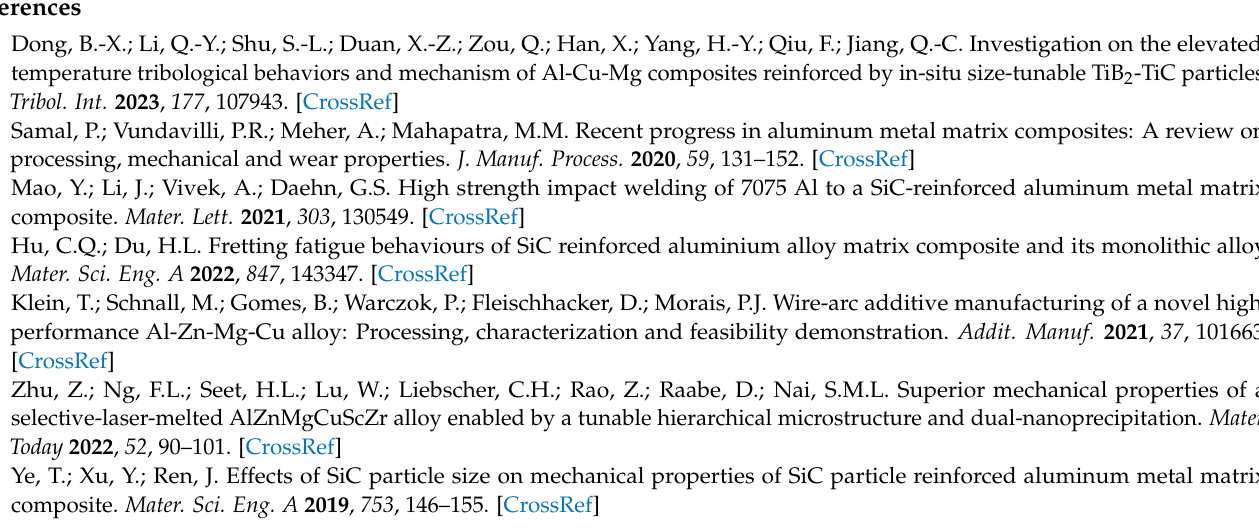
Figure 5. Results of friction and wear. ( a ) The variation curves of friction coefficient vs. sliding time and ( b ) the weight loss of the as-printed S0–S4 samples.